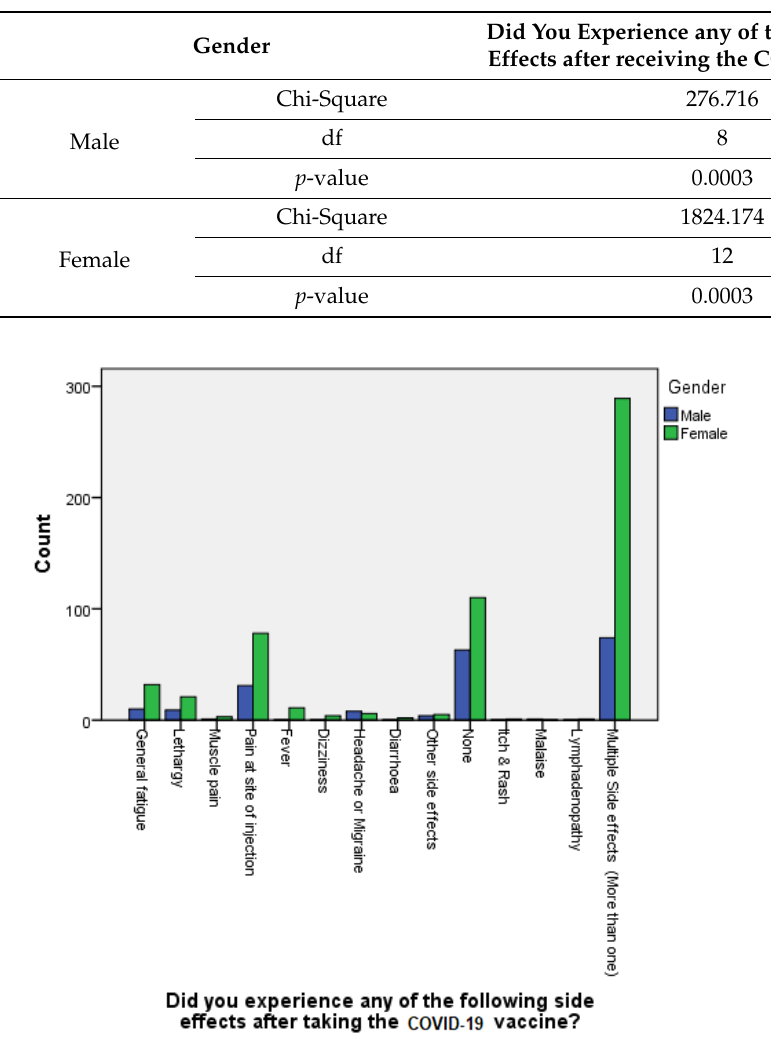
Table 7. Statistical results of chi-square tests (side effects, male vs. female).